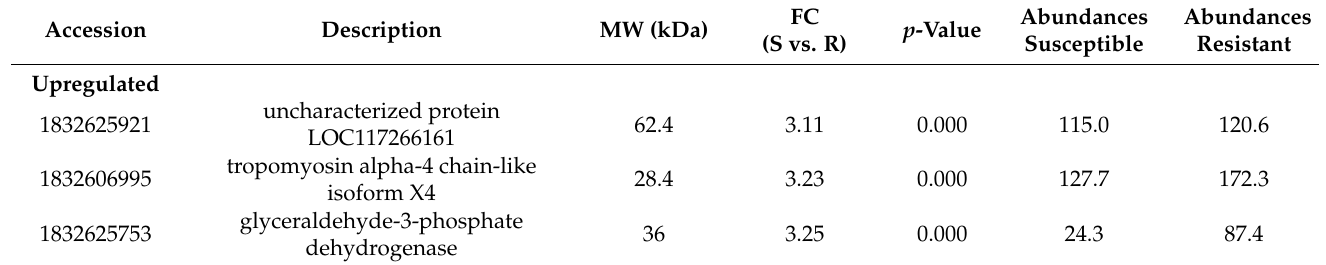
Table 4. Differentially expressed proteins were found to be in resistant when compared to